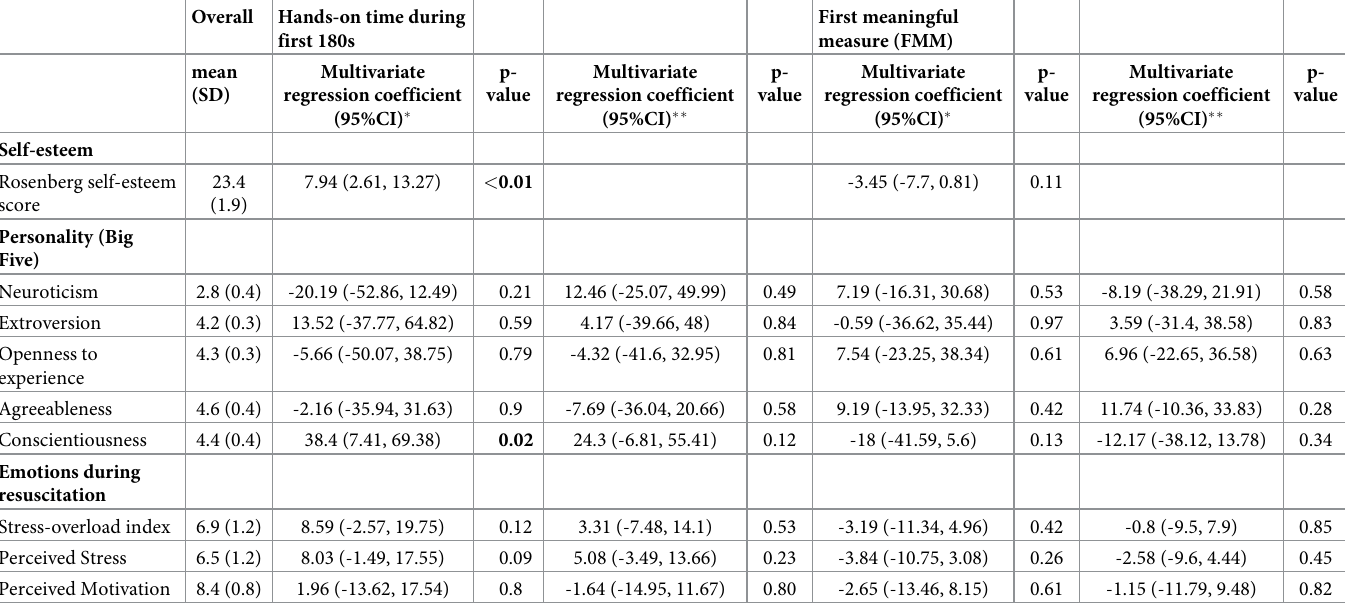
Table 1. Association of psychological variables of teams with CPR performance. Overall Hands-on time during first